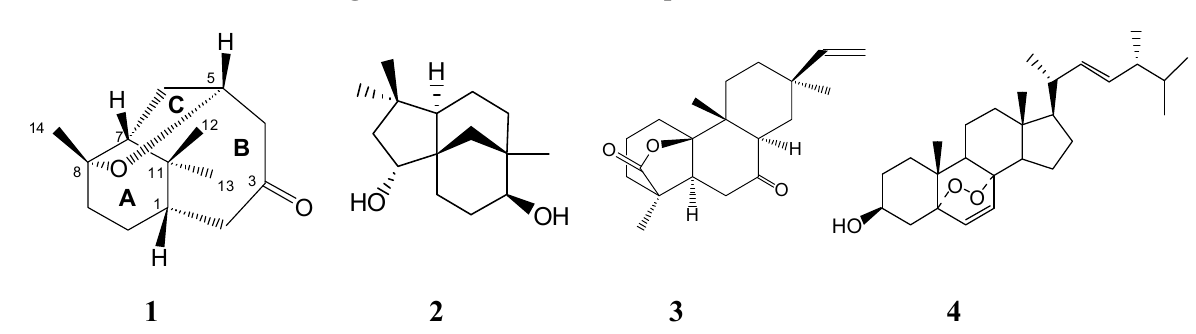
Figure 1. Structures of compounds 1-4